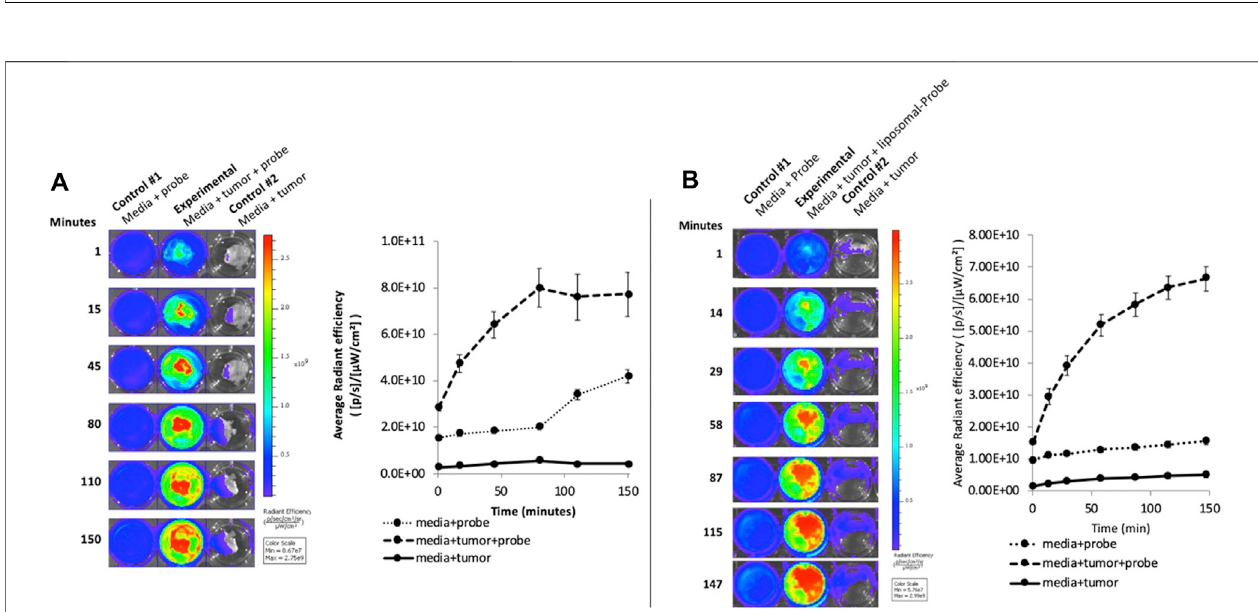
FIGURE 3 | Ex vivo activation of DFRA in aqueous (A) and liposome formulation (B) by 4175-Luc+ tumor slices: The image shows the fl uorescence activation of DFRA paintedontumorslicesovera2.5-htimecoursemeasuredusingtheIVISSpectrum,withexcitationand emissionat570and620 nm,respectively.Noincreasein fl uorescence was observed when the tumors were incubated in media alone. There was some non-speci fi c increase in fl uorescence after 90 min when the probe was incubated in media in the absence of tumor that was eliminated when the DFRA was packaged in liposomes. The graph shows the quanti fi cation of the fl uorescence signal from the wells in the image (Error bars (cid:2) standard deviation).